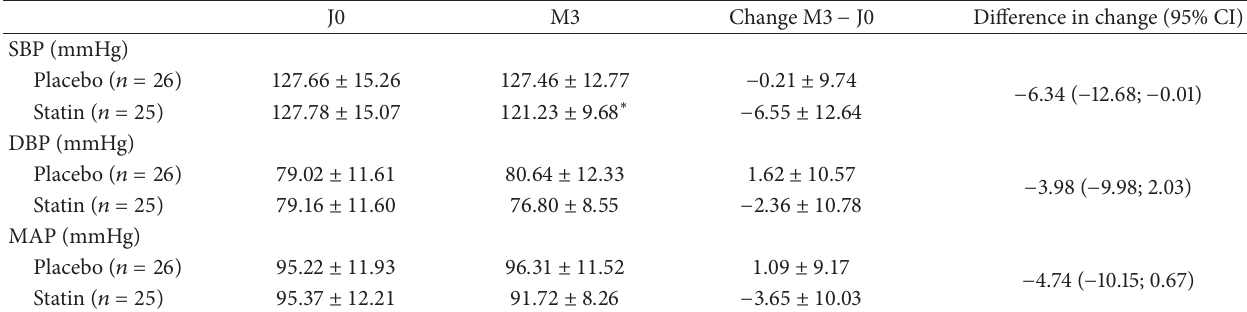
Table 3: Blood pressure at baseline (J0) and after 12 weeks (M3) of placebo or statin treatment. J0 M3 Change M3 − J0 Difference in change (95%